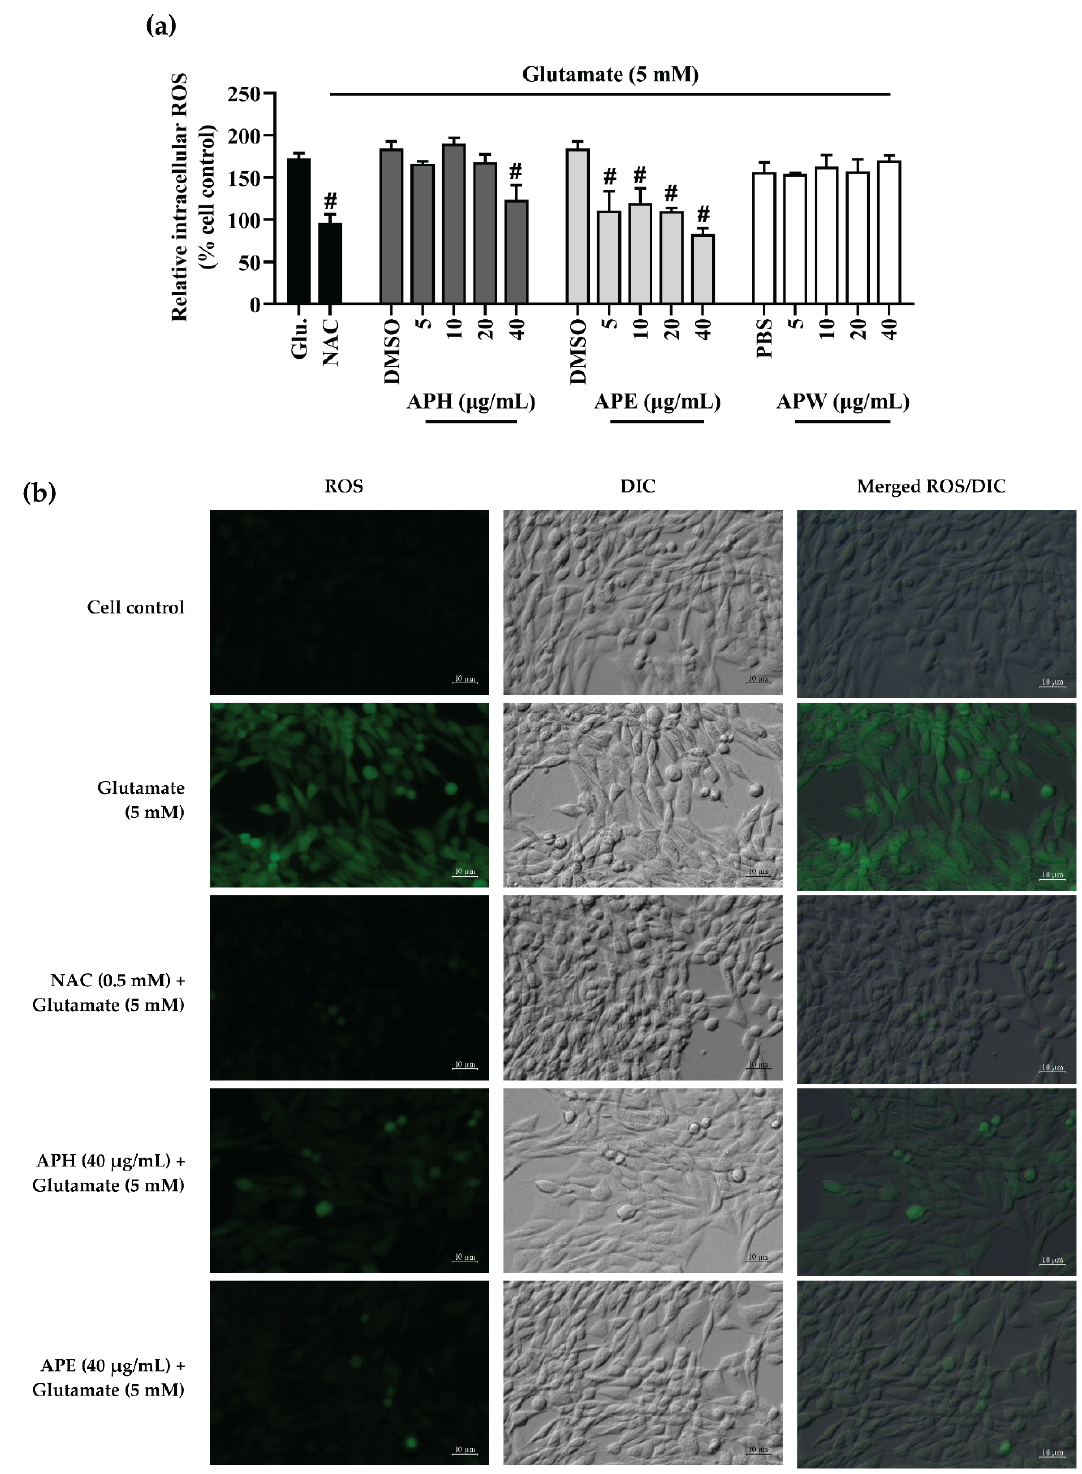
Figure 4. Intracellular reactive oxygen species (ROS) inhibitory effect of AP extracts co-treatment with 5 mM glutamate on HT-22 cells for 12 h. ( a ) The relative intracellular ROS of treatments compared to the cell control. N -acetyl cysteine (NAC, 0.5 mM) was used as the positive control. DMSO (0.1%, v / v ) and PBS (0.1%, v / v ) were used as the vehicle control. All data are shown as the mean ± SEM of triplicate values. Statistical significance was analyzed by one-way ANOVA, Dunnett test. # p < 0.05 versus the glutamate (Glu.) control. ( b ) Qualitative analysis of intracellular ROS in glutamate-induced HT-22 cells observed under fluorescence and differential interference contrast (DIC) microscopes at 10× magnification. The scale bar indicates 10 µm.